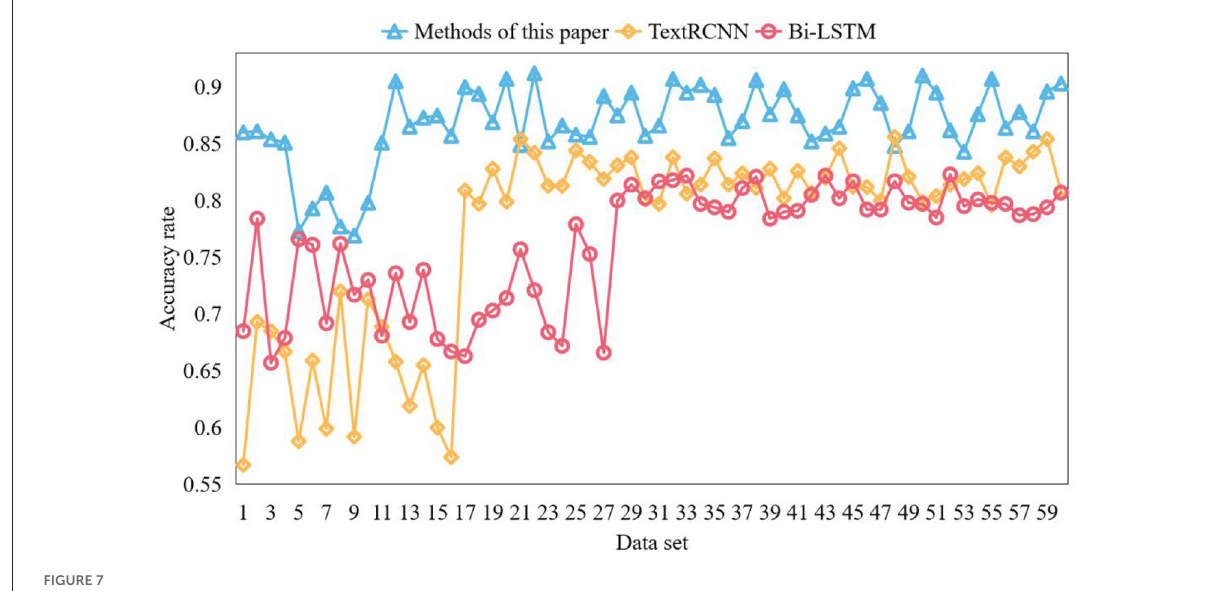
FIGURE7 Comparison of model accuracy.